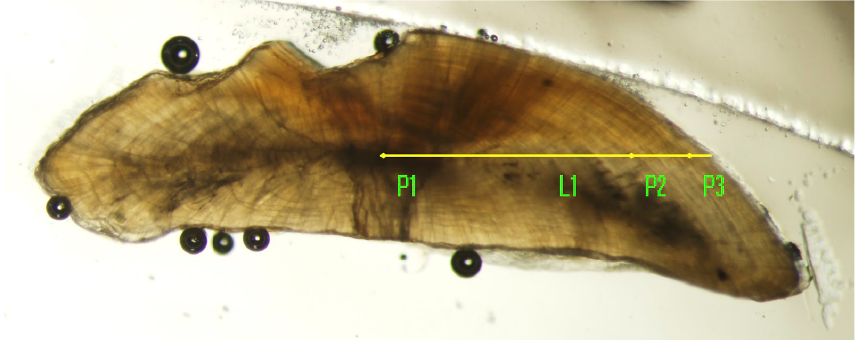
Figure 6. Image of sectioned otolith with features indicating the core (P1), first annulus (P2) and second annulus (P3). The line feature (L1) was used to ensure consistent placement of markers for measurements between